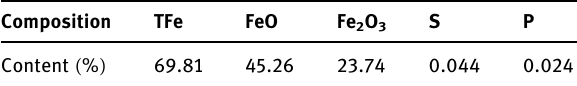
Table 3: Chemical composition of the oxide scale Composition